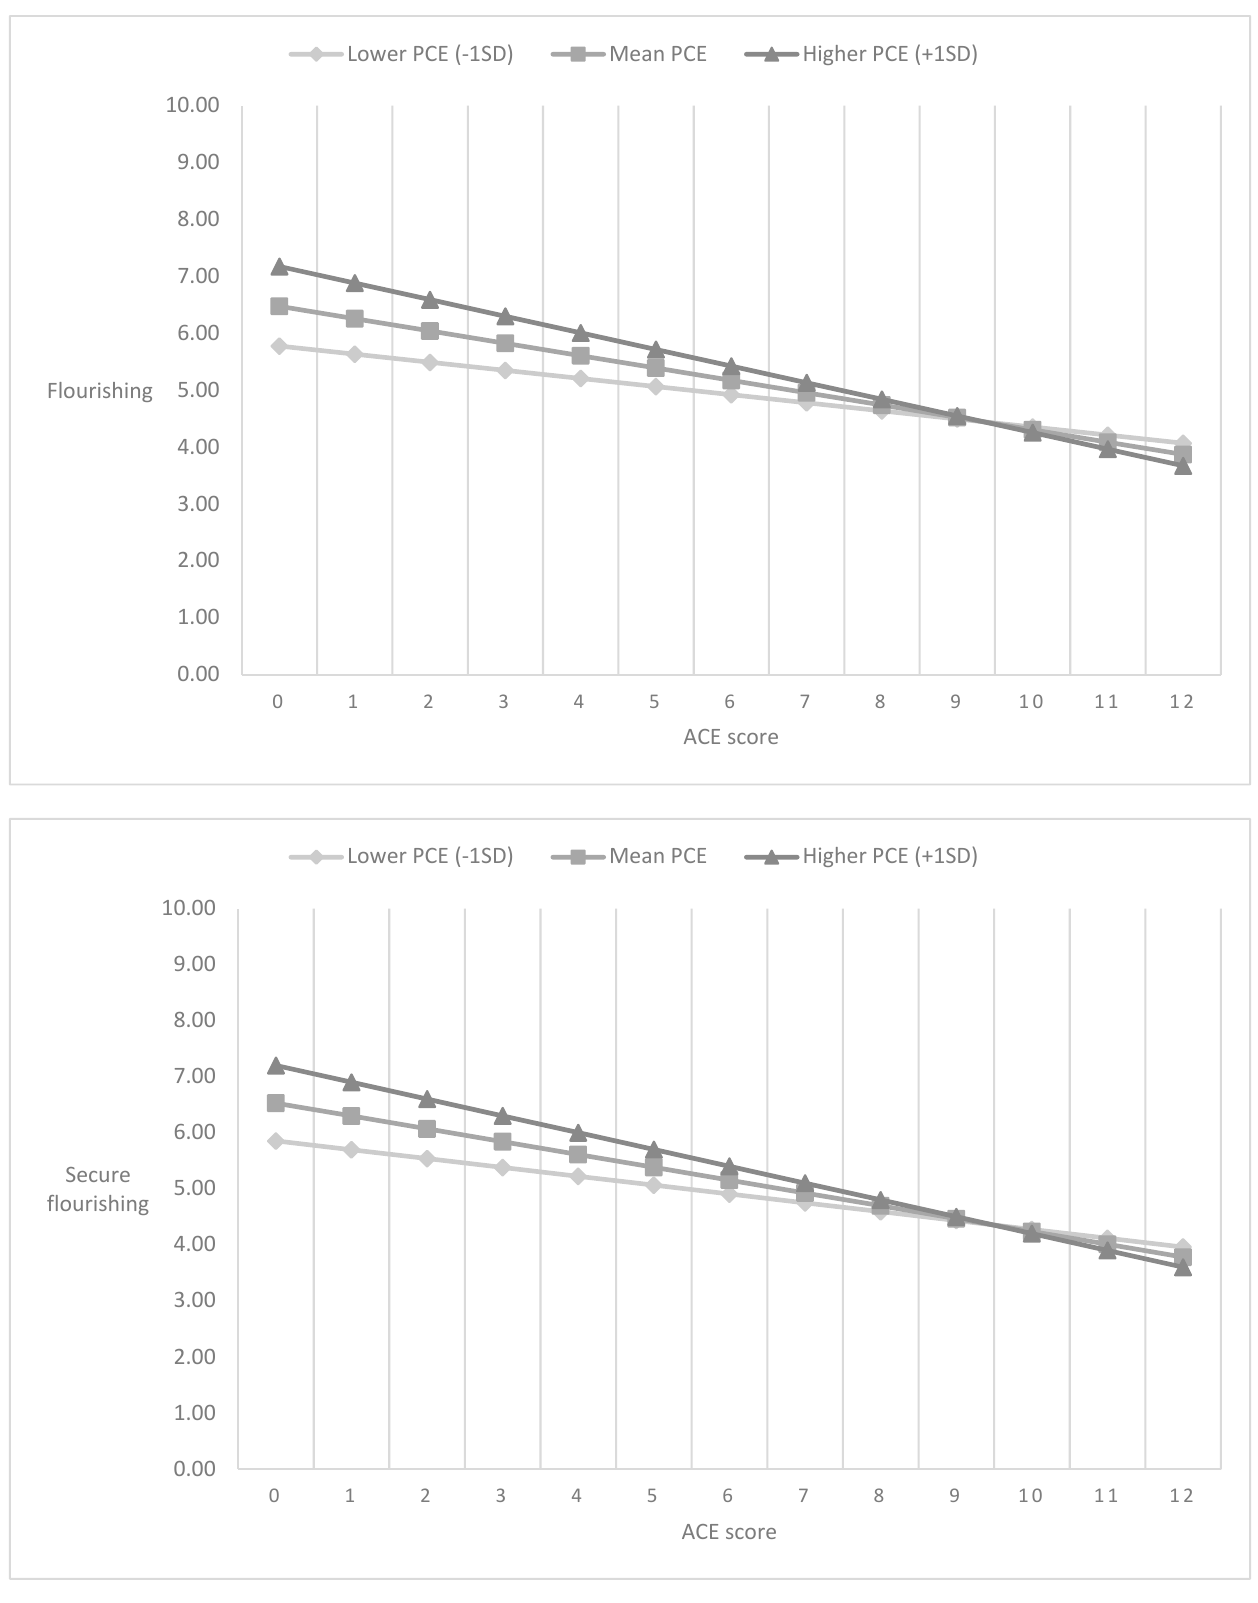
Figure 1. Flourishing indices by the cumulative ACEs scores and PCEs level.